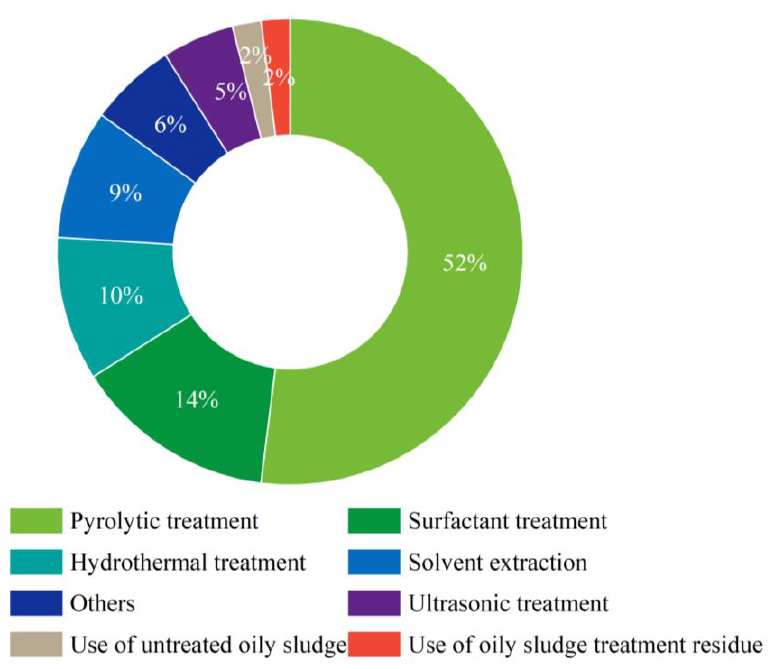
Figure 5. A donut chart showing the percent share of journal articles dealing with different valoriza- tion treatment methods .